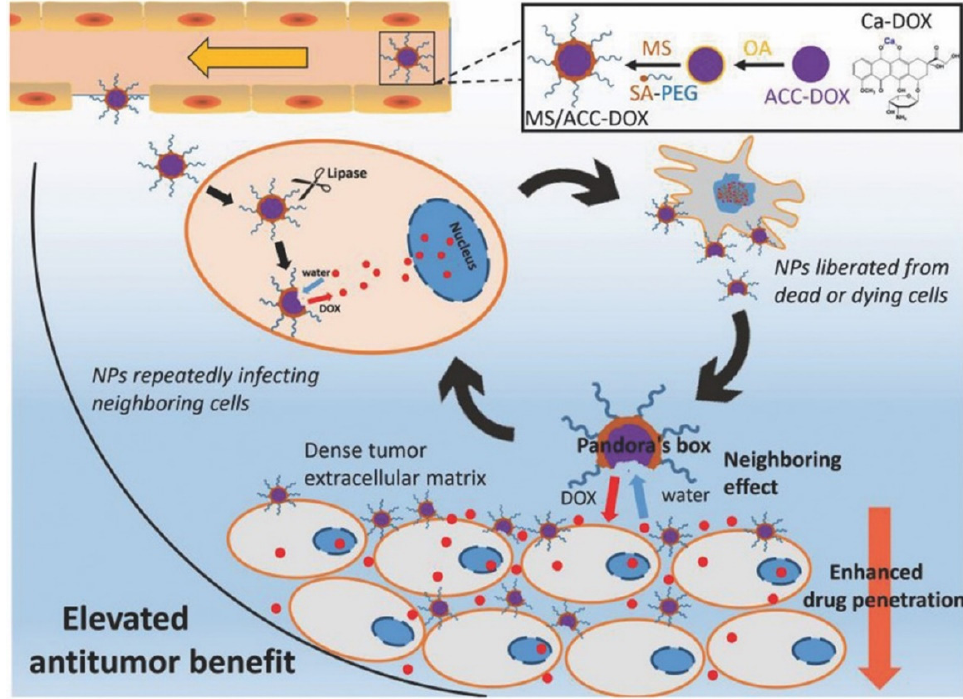
Figure 3. Illustration of the formation and elevation of the designed CaCO 3 NPs. Reprinted with permission. Copyright 2018, Wiley-VCH [29].